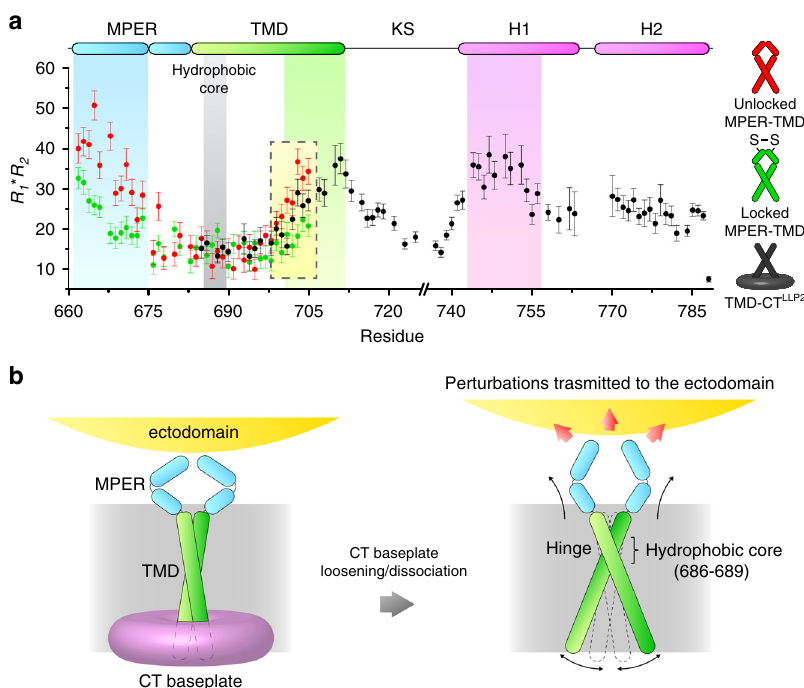
Fig. 5 Conformational coupling between the Env CT and ectodomain. a Backbone conformational dynamics of the unlocked MPER – TMD (red), locked MPER – TMD (green) and TMD – CT LLP2 (black) probed by the product of 15 N R 1 and R 2 relaxation rates, which re fl ects ms – μ s motion. Error bars represent the uncertainty derived from R 1 and R 2 fi tting errors. The regions characterized by higher R 1 R 2 , i.e., the MPER, the C-terminal part of the TMD, and its interacting CT region (H1), are highlighted in cyan, green, and purple, respectively. The position of the hydrophobic core (or the TM hinge) is shown in gray. The yellow box highlights the decrease of R 1 R 2 in the C-terminal part of the TMD due to locking the MPER or CT presence. b Proposed mechanism of CT-ectodomain coupling mediated by the TMD. For simplicity, only two chains of the trimer are illustrated. Left: the CT baseplate con fi nes the TMD motion, important for stabilizing the Env trimer in the prefusion state. Right: deletion of the CT baseplate or disruption of CT – TMD interactions allows greater TMD hinge motion, destabilizing the MPER, which in turn modulates the antigenic structure of the ectodomain. Source data are provided as a Source data fi